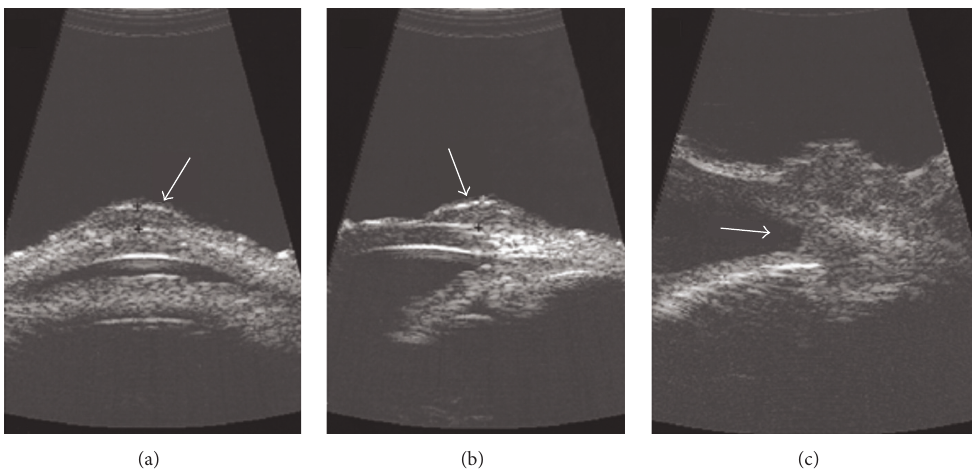
Figure2:20 MHztransverse(a)andlongitudinal(b)ultrasoundbiomicroscopysectionsofconjunctivalintraepithelialneoplasiademonstrate hyperechoic tumor surface (arrows) and hypoechoic stroma. (c) 20 MHz UBM image taken from a patient with squamous cell carcinoma demonstrates blunting of the anterior chamber angle (arrow) which correlated to anterior chamber angle invasion on histopathology